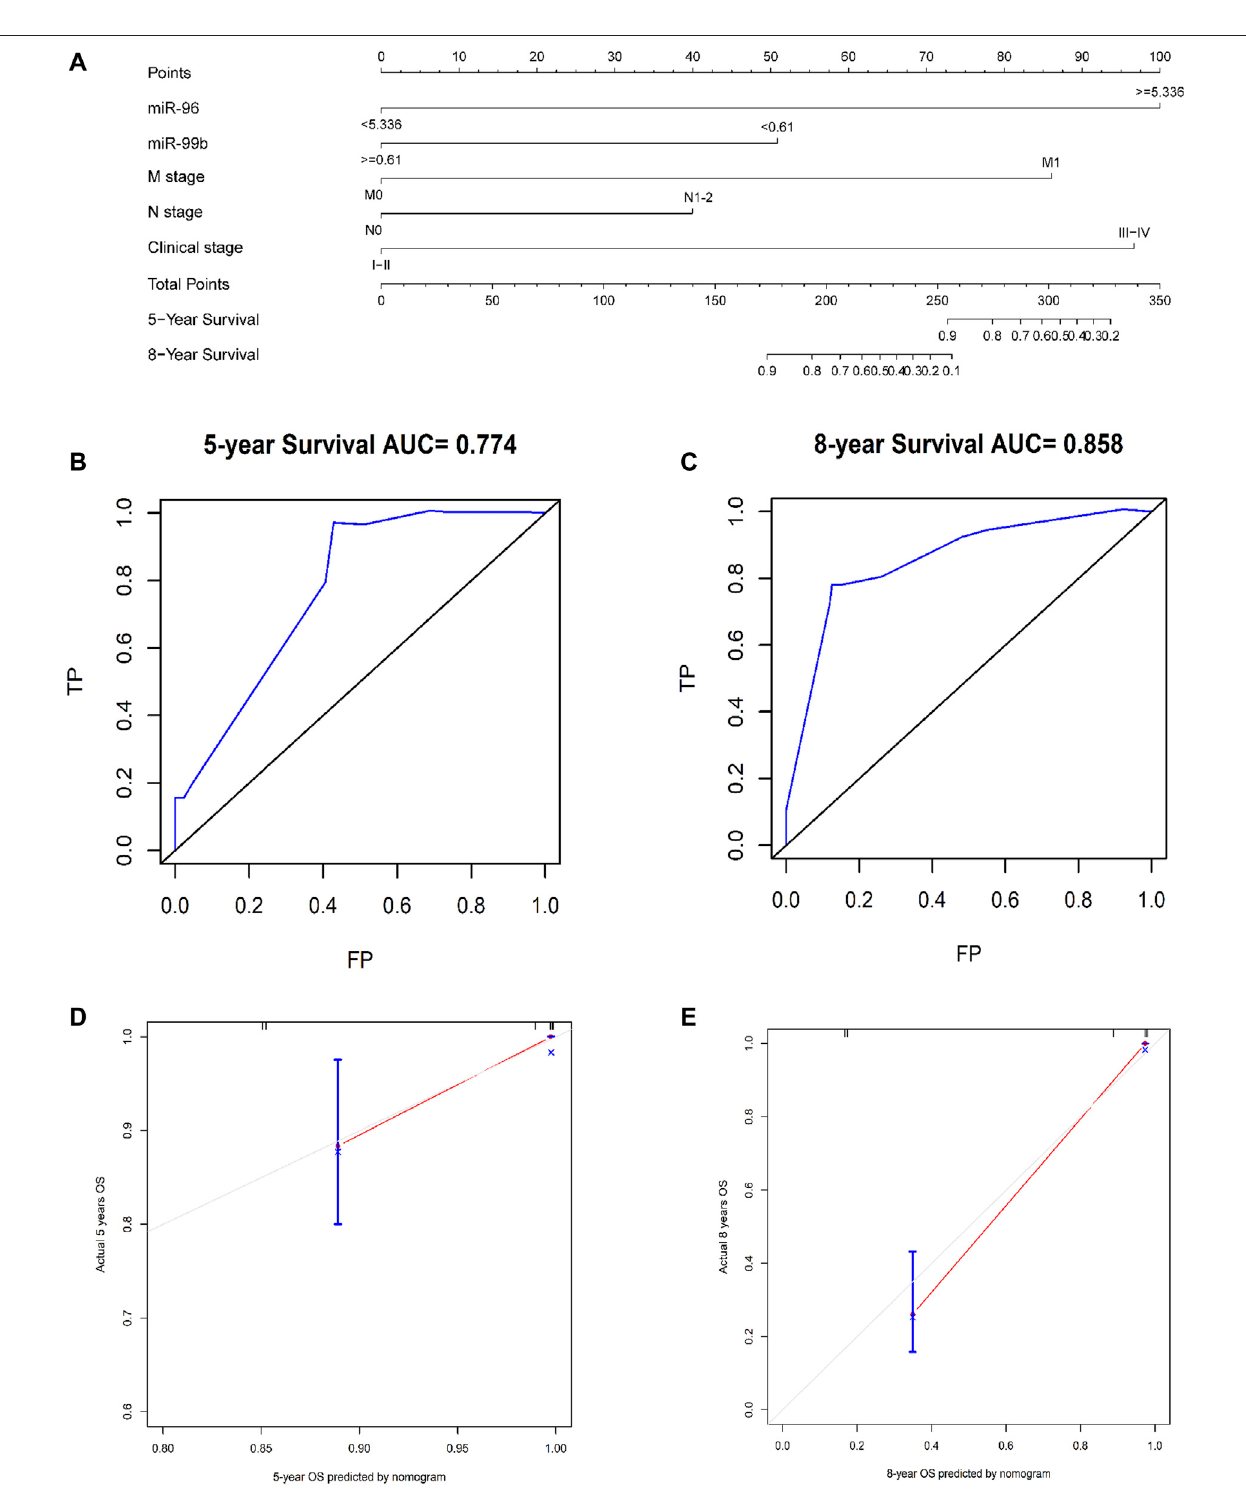
FIGURE 6 | Using nomograms to predict OS in patients with CRC at 5 and 8 years. (A) A composite nomogram prognostic model based on miRNAs and clinical parameters. (B,C) Use nomogram to perform ROC analysis of OS. (D,E) 5-years and 8-years OS calibration curve of nomogram. Note: TP, true possibility; FP, false